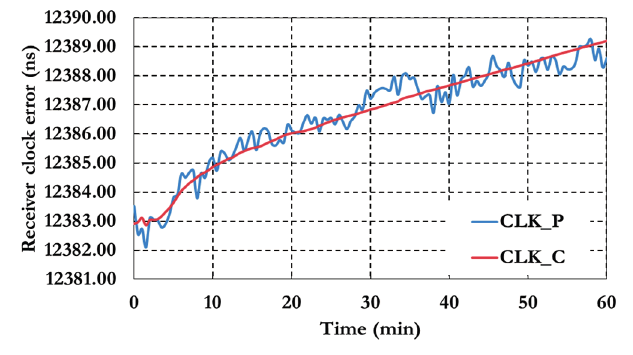
Figure 10. Receiver clock errors of the GPS decoupled clock model.